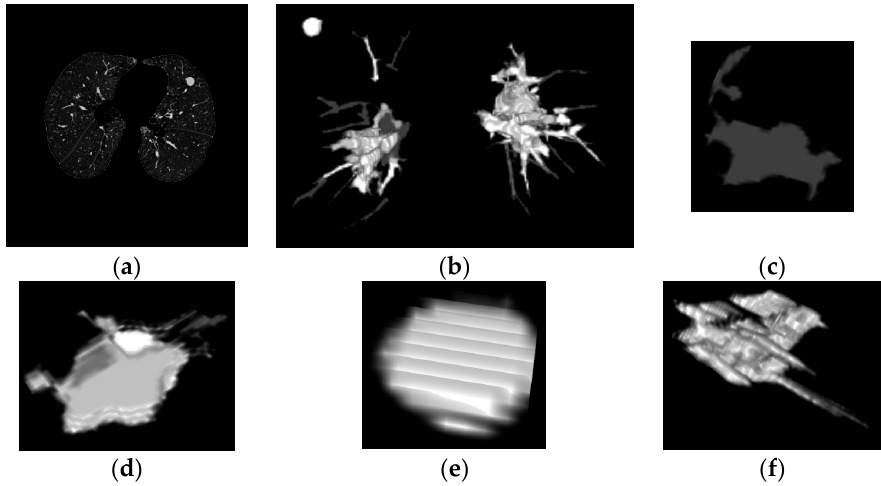
Figure 5. Lung nodule detection with false positives ( a ) CT image showing all the structures; ( b ) Lung 3D reconstruction; ( c – f ) all possible candidates before classification; ( c ) and ( d ) Non ‐ nodules; ( e ) lung nodules determine after classification; ( f ) False positive presented in the detection.